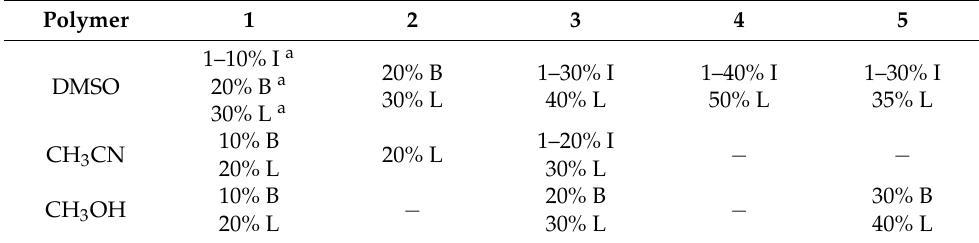
Table 2. Solution properties of poly(pyridinium salt)-fluorenes 1 – 5